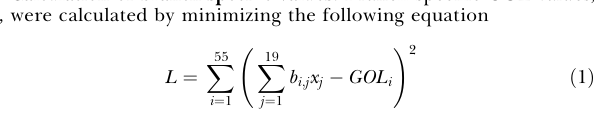
Figure S1. Chromosomal Map Reorganization between S. cerevisiae and C. glabrata Each chromosome from S. cerevisiae (SACE_A to P) is represented in a circle with the 13 chromosomes from C. glabrata (CAGL_A to M). Each line joins two orthologs and the color of the lines represents the percentage of similarity between orthologous gene products (green (cid:2) 50% (cid:2) cyan (cid:2) 60% (cid:2) blue (cid:2) 70% (cid:2) magenta (cid:2) 80% (cid:2) dark magenta (cid:2) 90% (cid:2) red). Found at DOI: 10.1371/journal.pgen.0020032.sg001 (1.1 MB PDF). Figure S2. Chromosomal Map Reorganization between K. lactis and A. gossypii Each chromosome from K. lactis (KLLA_A to F) is represented in a circle with the seven chromosomes from A. gossypii (ASGO_A to G). Each line joins two orthologs and the color of the lines represents the percentage of similarity between orthologous gene products (green (cid:2) 50% (cid:2) cyan (cid:2) 60% (cid:2) blue (cid:2) 70% (cid:2) magenta (cid:2) 80% (cid:2) dark magenta (cid:2) 90% (cid:2) red). Found at DOI: 10.1371/journal.pgen.0020032.sg002 (630 KB PDF). Figure S3. Distribution of the Length of the Syntenic Blocks between S. cerevisiae and C. glabrata (Black Bars) and between K. lactis and A. gossypi (Gray Bars) Found at DOI: 10.1371/journal.pgen.0020032.sg003 (23 KB